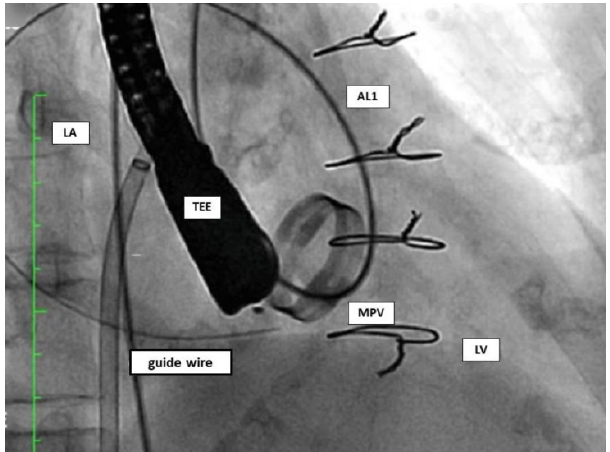
Figure 9. Retrograde approach. AL1: Amplatz Left catheter; LA: left atrium; LV: left ventricle; MPV: mitral prosthetic valve; TEE: transoesophageal echocardiography.